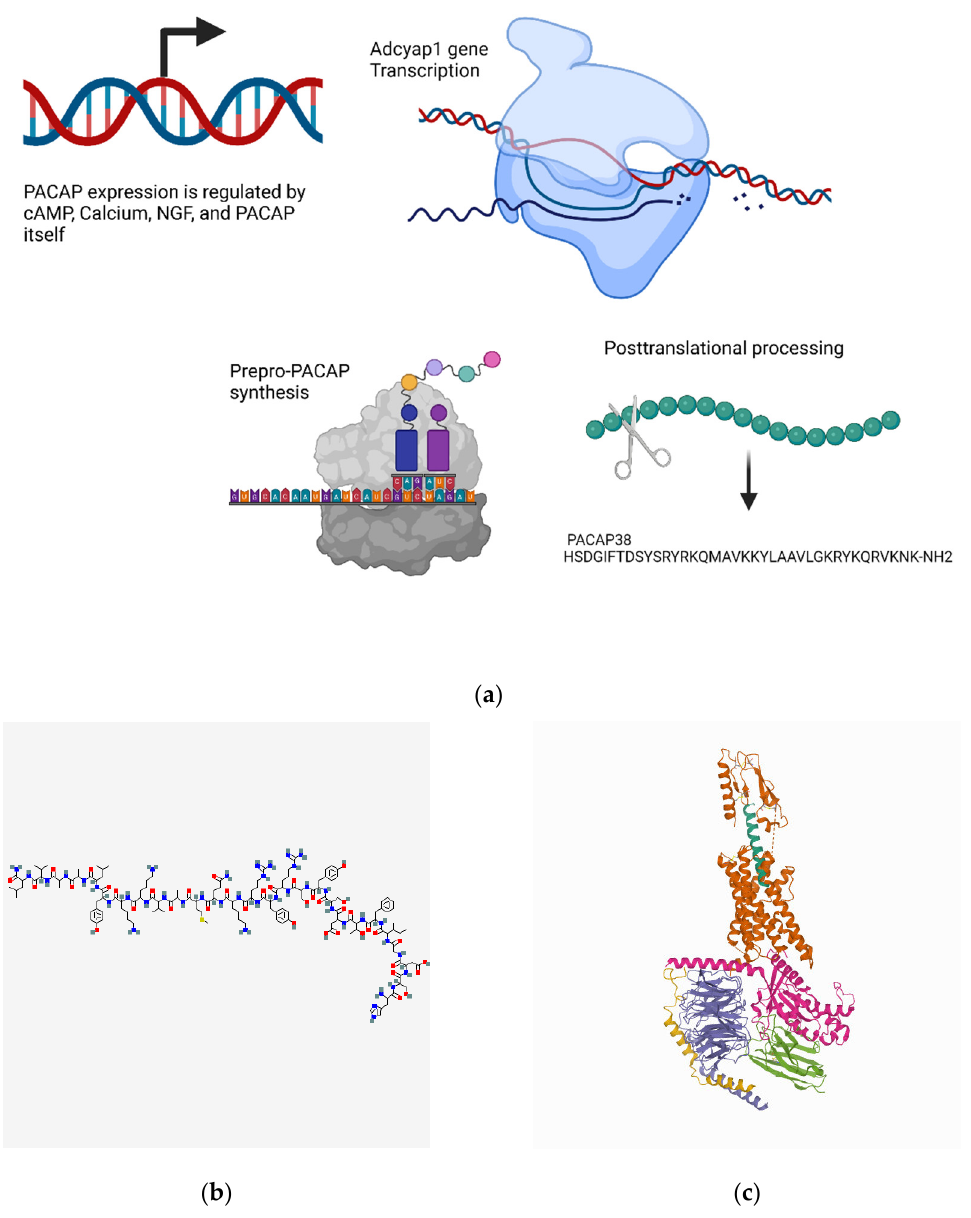
Figure 6. Neuropeptide PACAP and PAC1R: ( a ) transcription and synthesis of PACAP (created with BioRender.com accessed on 22 October 2021); ( b ) 2D structure image of PACAP (https:// pubchem.ncbi.nlm.nih.gov/compound/137699541#section=2D-Structure, accessed on 22 October 2021); ( c ) Cryo-EM structure of the human PAC1 receptor coupled to an engineered heterotrimeric G protein. Image from the RCSB PDB (rcsb.org) of PDB ID 6LPB